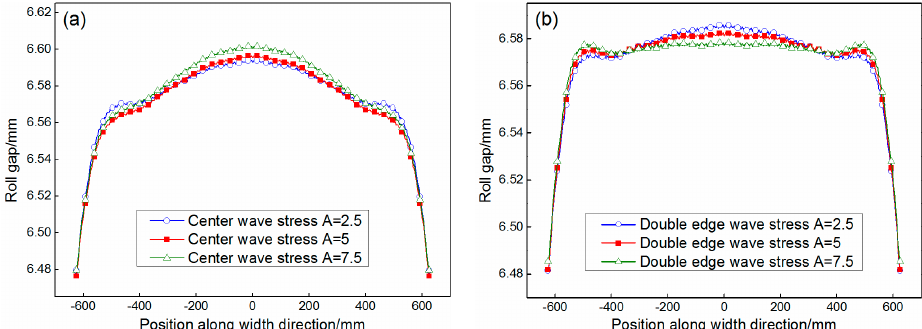
Figure 16. Effect of quadratic wave stress on the roll gap profile under different amplitudes of stress deviation: ( a ) middle wave stress; and ( b ) double-edge wave stress.